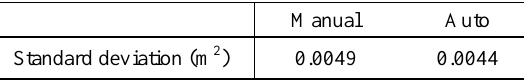
Table 5. Comparison of manual and automatic methods through standard deviation of area